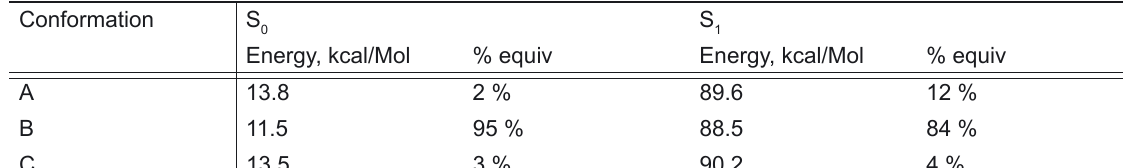
) in 2a; AM1 calculation.